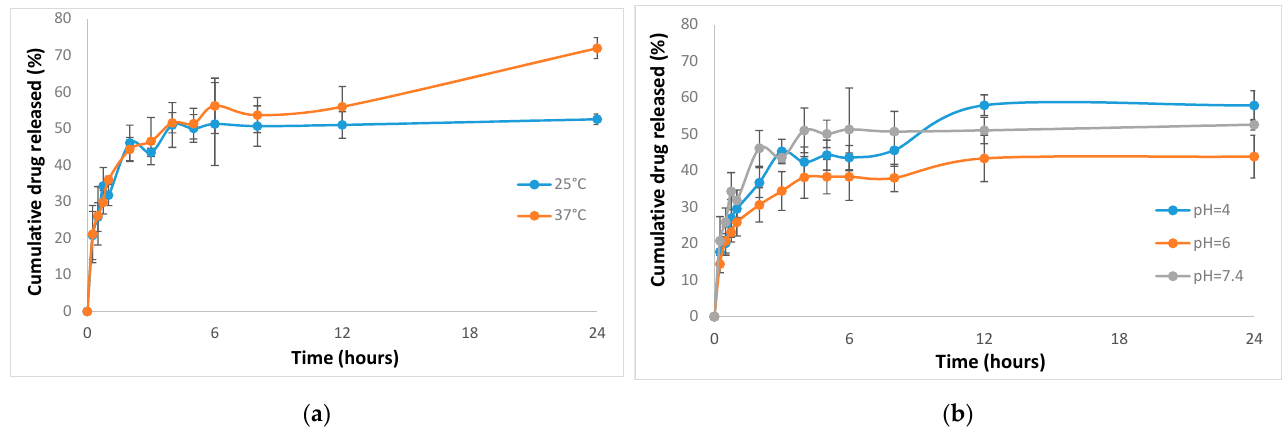
Figure 4. In vitro drug release profile for NFLX in Cremohor EL, Pluronic F127 and CrEL-Pl F127 ( α = 0.2) mixed micelles.